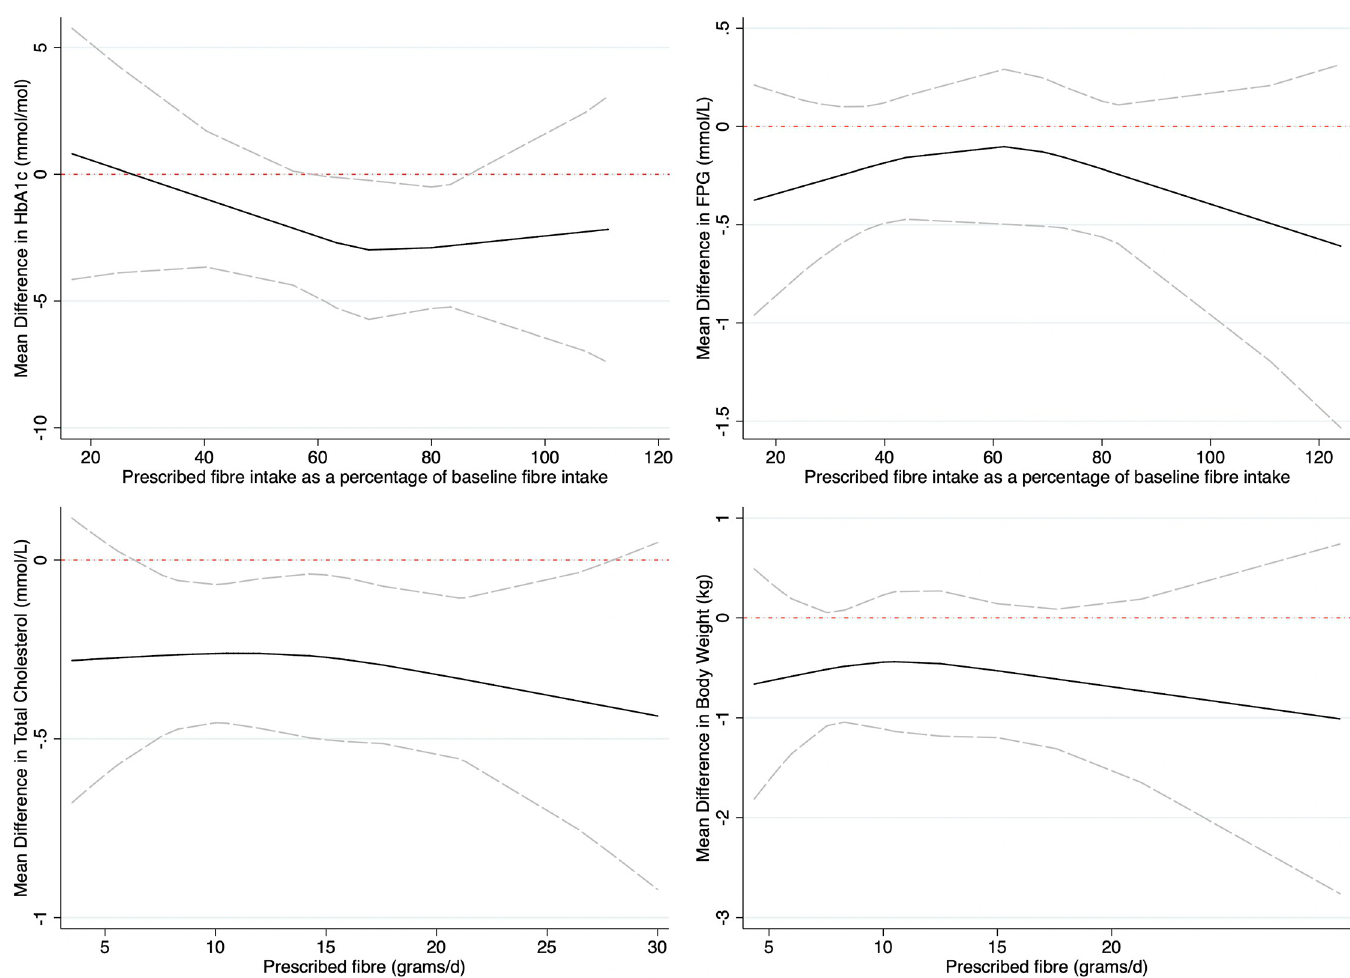
Fig 4. Dose response curves of increasing fibre intakes and key cardiometabolic risk factors. HbA1c (top left, data from 16 trials of 758 participants), fasting glucose (top right, data from 18 trials of 979 participants), total cholesterol (bottom left, data from 25 trials of 1,178 participants), and body weight (bottom right, data from 18 trials of 877 participants) from trials of increasing fibre intakes. The 95% CIs are shown as dashed lines. FPG, fasting plasma glucose.